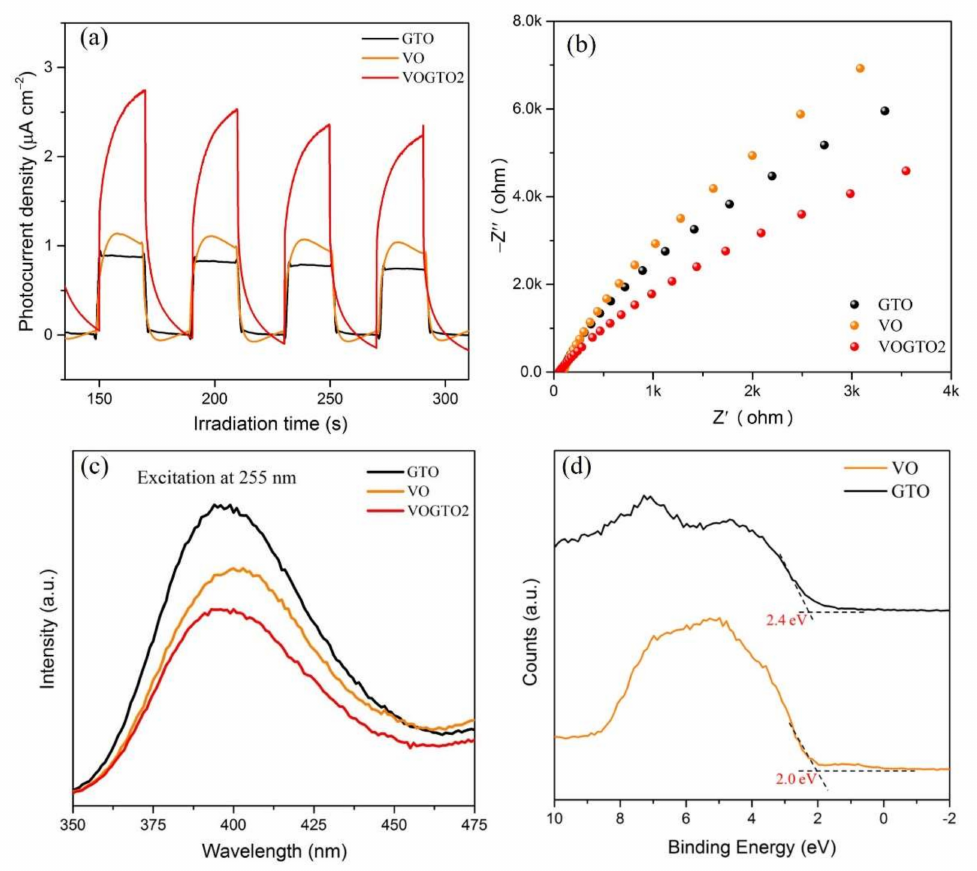
Figure 3. The ( a ) photocurrent density, ( b ) EIS response, ( c ) PL spectra and ( d ) XPS valence band spectra of VO, GTO, and